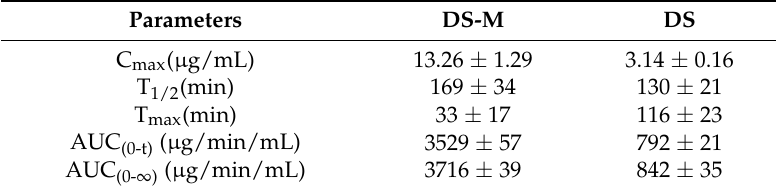
Table 3. Pharmacokinetic parameters of DS in DS-loaded micelle and pure